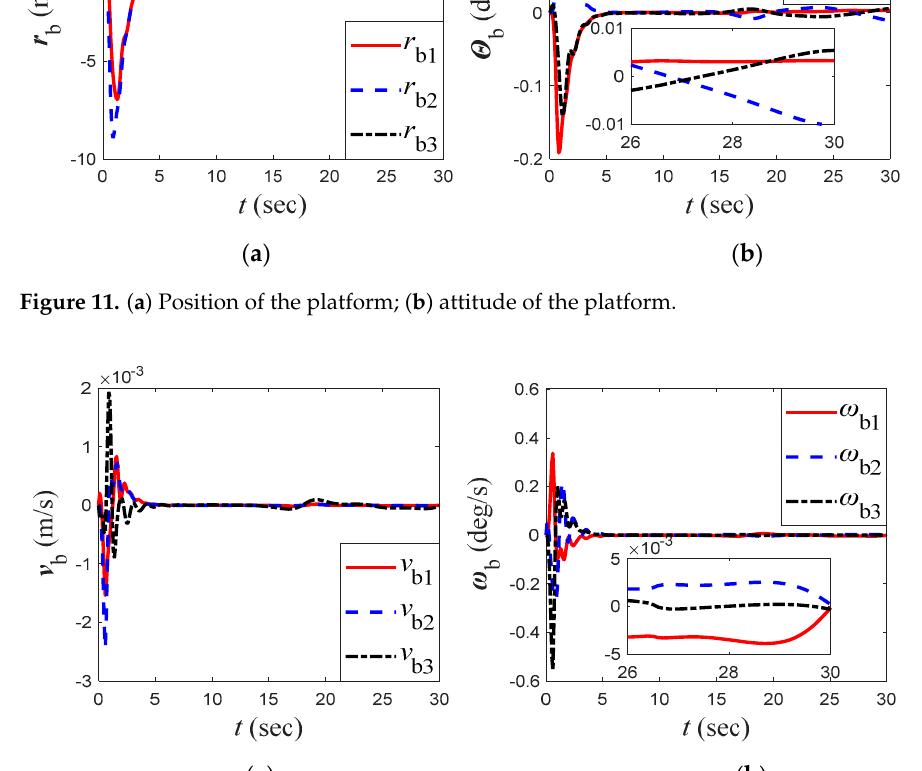
Figure 12. ( a ) Linear velocities of the platform; ( b ) angular velocities of the platform.